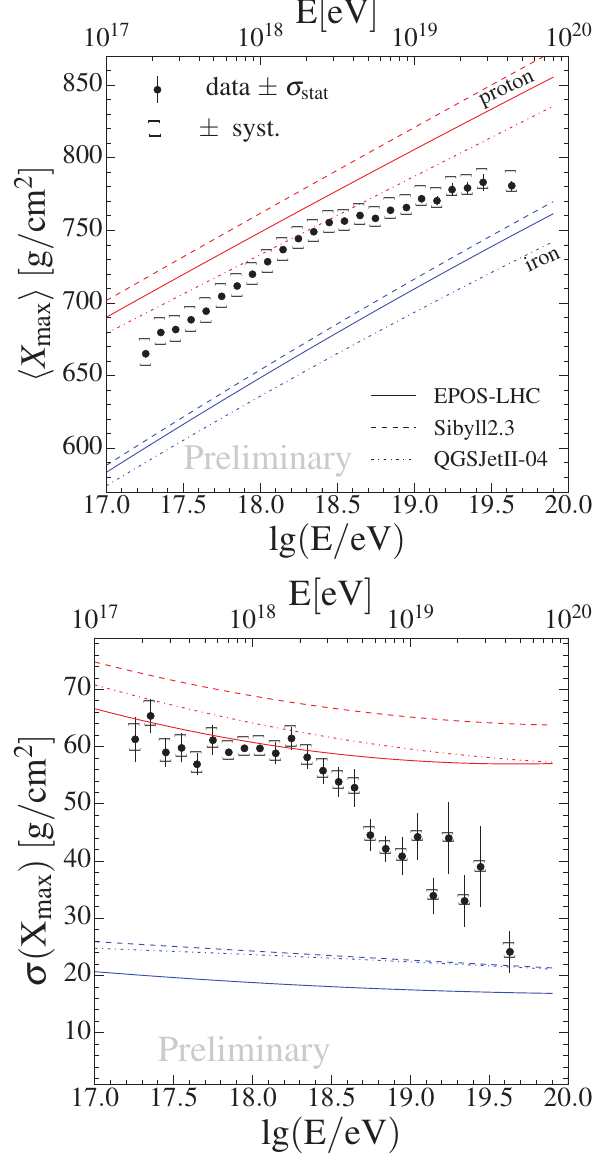
(cid:105) (top) and σ ( X ) (bottom) max max